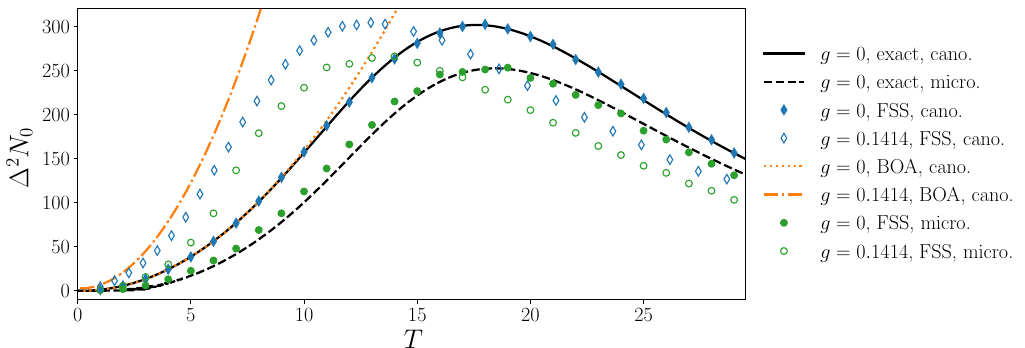
Figure 4: Fluctuations of Bose gas containing N = 100 atoms as a function of tem- perature in a 1D harmonic trap. The fluctuations with and without interactions are computed with several methods: FSS method (symbols), Bogoliubov approach (or- ange dotted and dot-dashed lines), and exact methods for the non-interacting gas (black solid and dashed lines). Interactions lead to a shift of the temperature of peak fluctuations, resulting in increased fluctuations at low temperature. In addition cal- culations using a microcanonical (black dashed line, green symbols) ensemble show the significantly lower fluctuations expected in this case. The interaction strength g (cid:198) ħ h 3 ω/ m and ħ h ω/ k and temperature T are given in units of , B